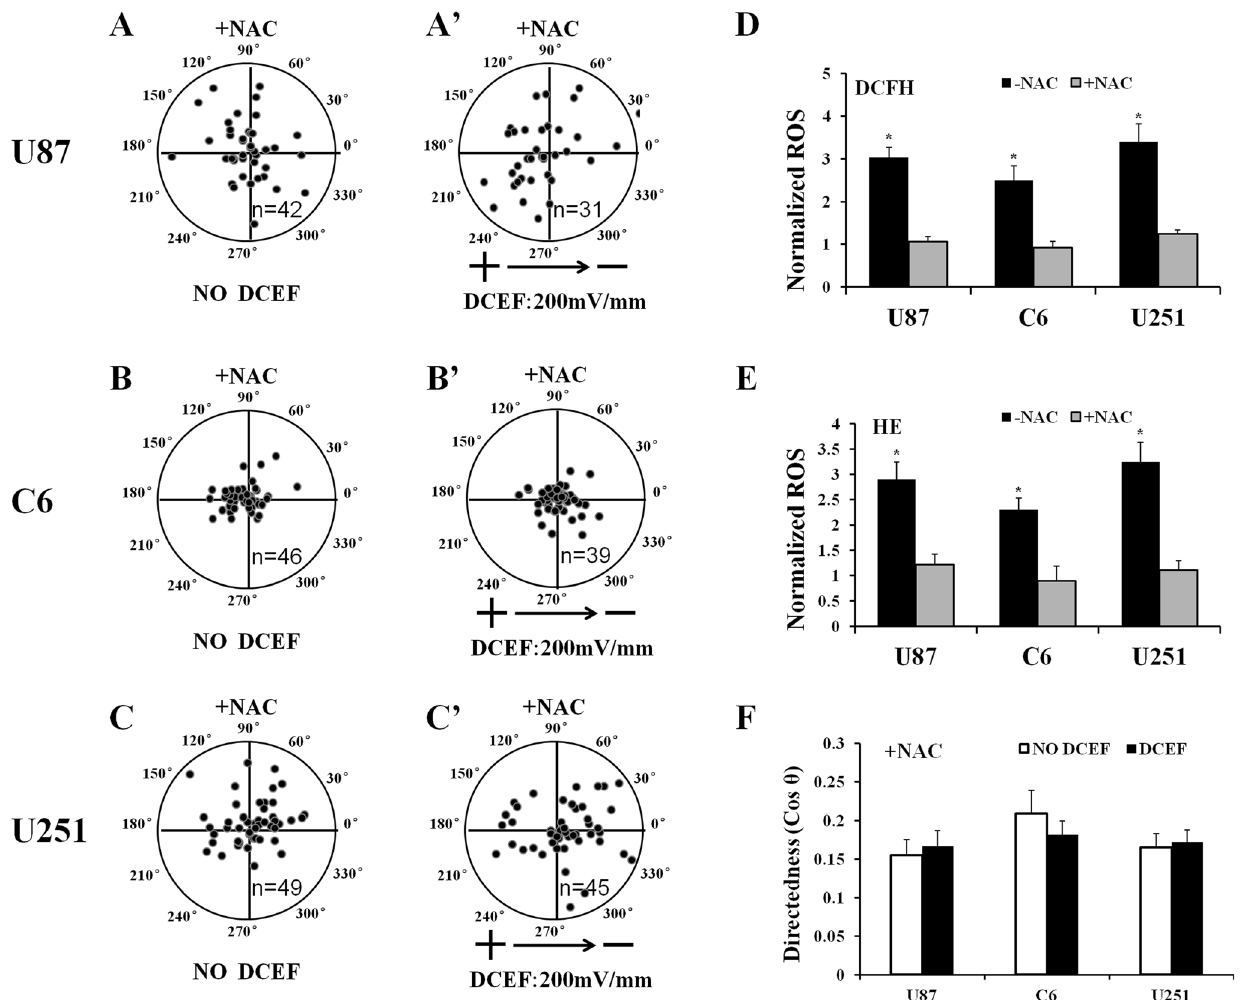
Figure 3. NAC blocks DCEF-induced directional migration of glioma cells. U87 (A and A 9 ), C6 (B and B 9 ) and U251 (C and C 9 ) glioma cells migrate in all directions after two hours of NAC (10 mM) pretreatment with or without stimulation by a 200 mV/mm DCEF. ROS generation in cells stimulated with a 200 mV/mm DCEF for 30 minites with or without pretreatment with NAC (10 mM) as detected by DCFH-DA (D). Superoxide was detected by HE (E). Analysis of direction (cos h ) of U87 glioma cell migration (F). Data are expressed as the mean 6 standard deviation (SD) (n=3). * Compared with the NAC-pretreated cells, P , 0.05.